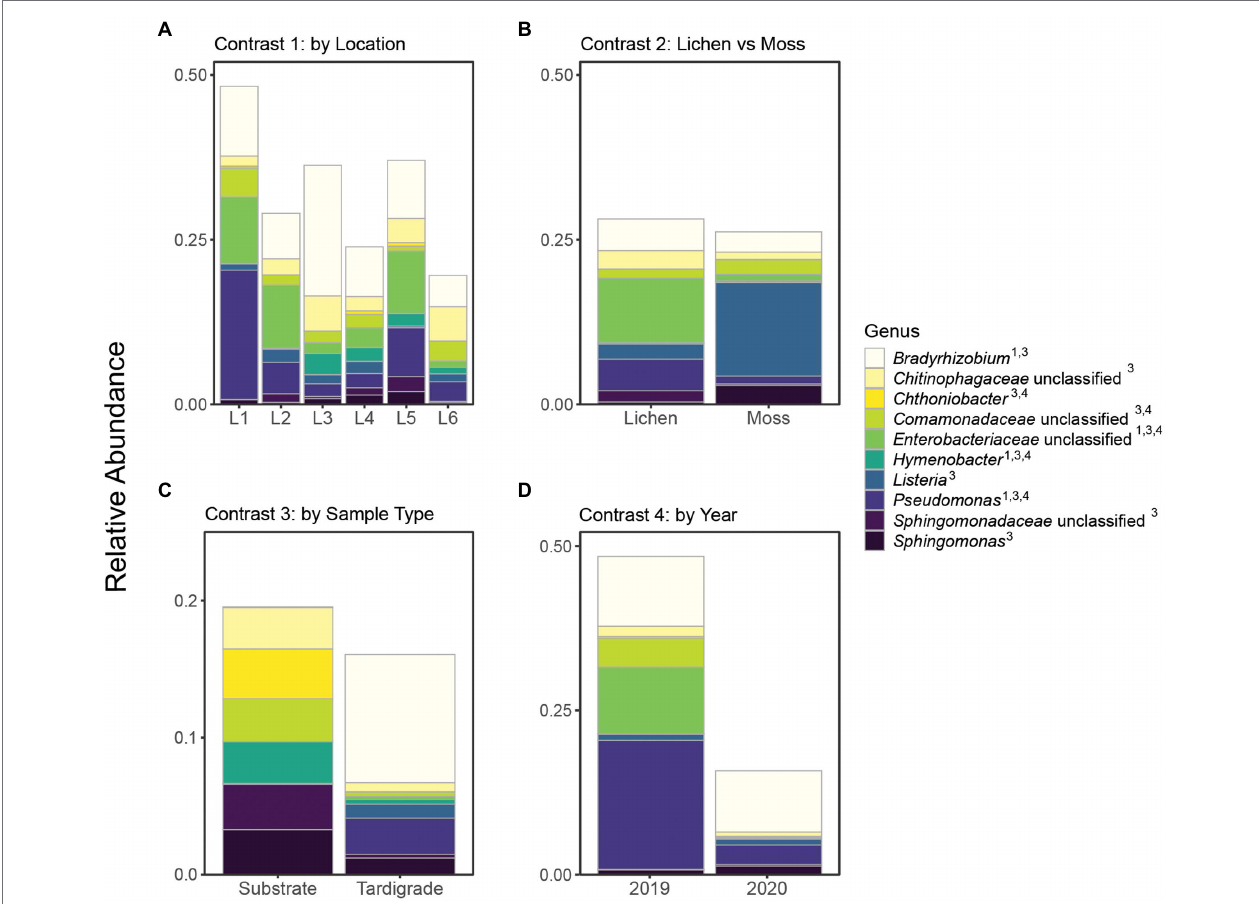
FIGURE 3 | Relative abundance of top 10 genera (identifiable at least to family level) shown across all contrasts. Superscript numbers indicate the contrasts in which a given genus was significantly differentially abundant. Location names (Location 1 through Location 6) are abbreviated as L1 through L6. (A) Contrast 1, (B) Contrast 2, (C) Contrast 3, and (D) Contrast